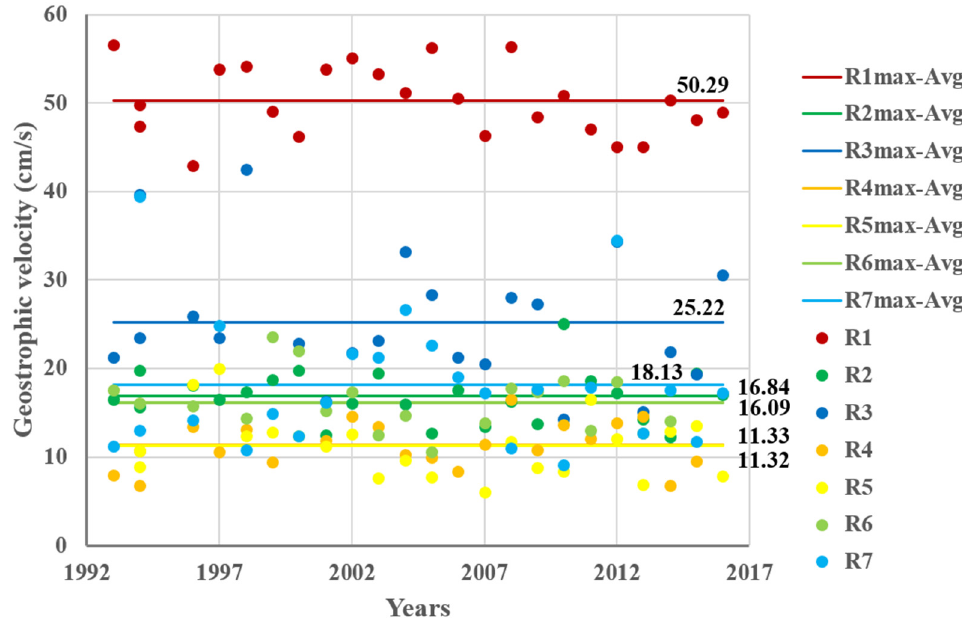
Figure 9. The maximum (represented with circles) and annual average velocity (represented with lines) of the currents in the migration channels (R1-R7).